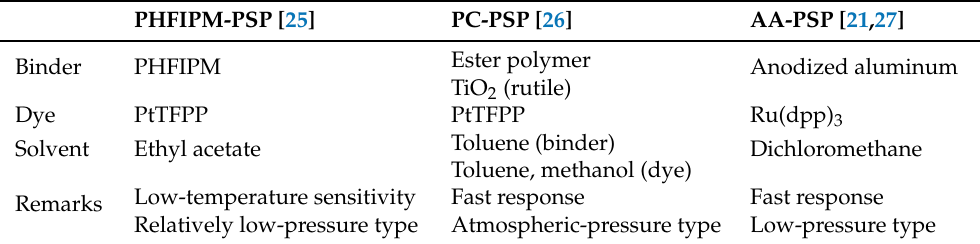
Table 2. Composition of tested